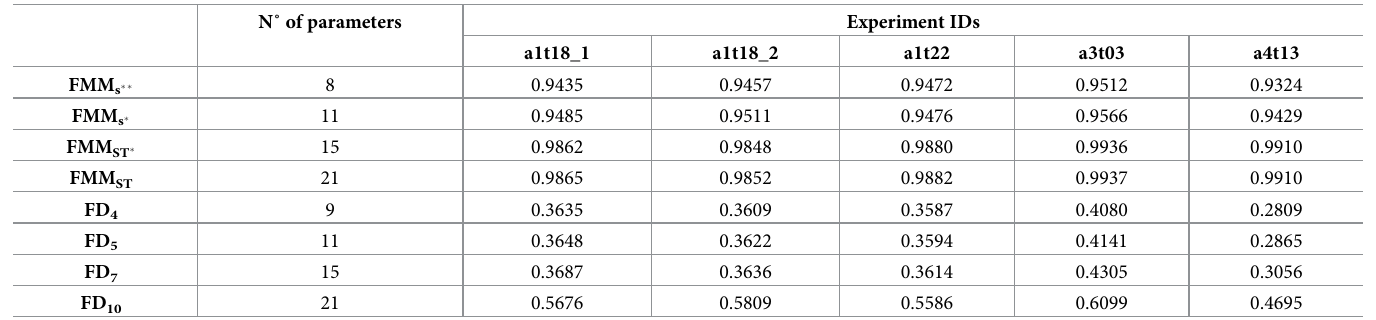
Table 6. R 2 values of the different FMM and FD models for the signals extracted from the SGAMP database. N˚ of parameters Experiment